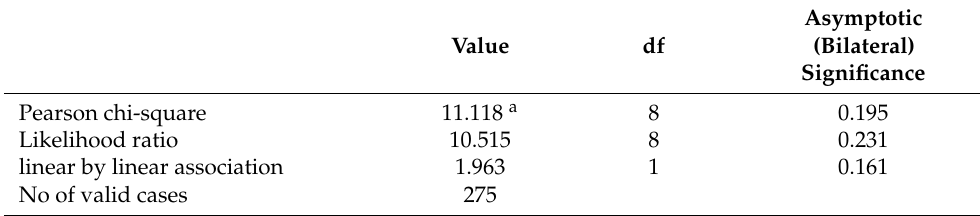
Table 12. Chi-square tests: remote work and